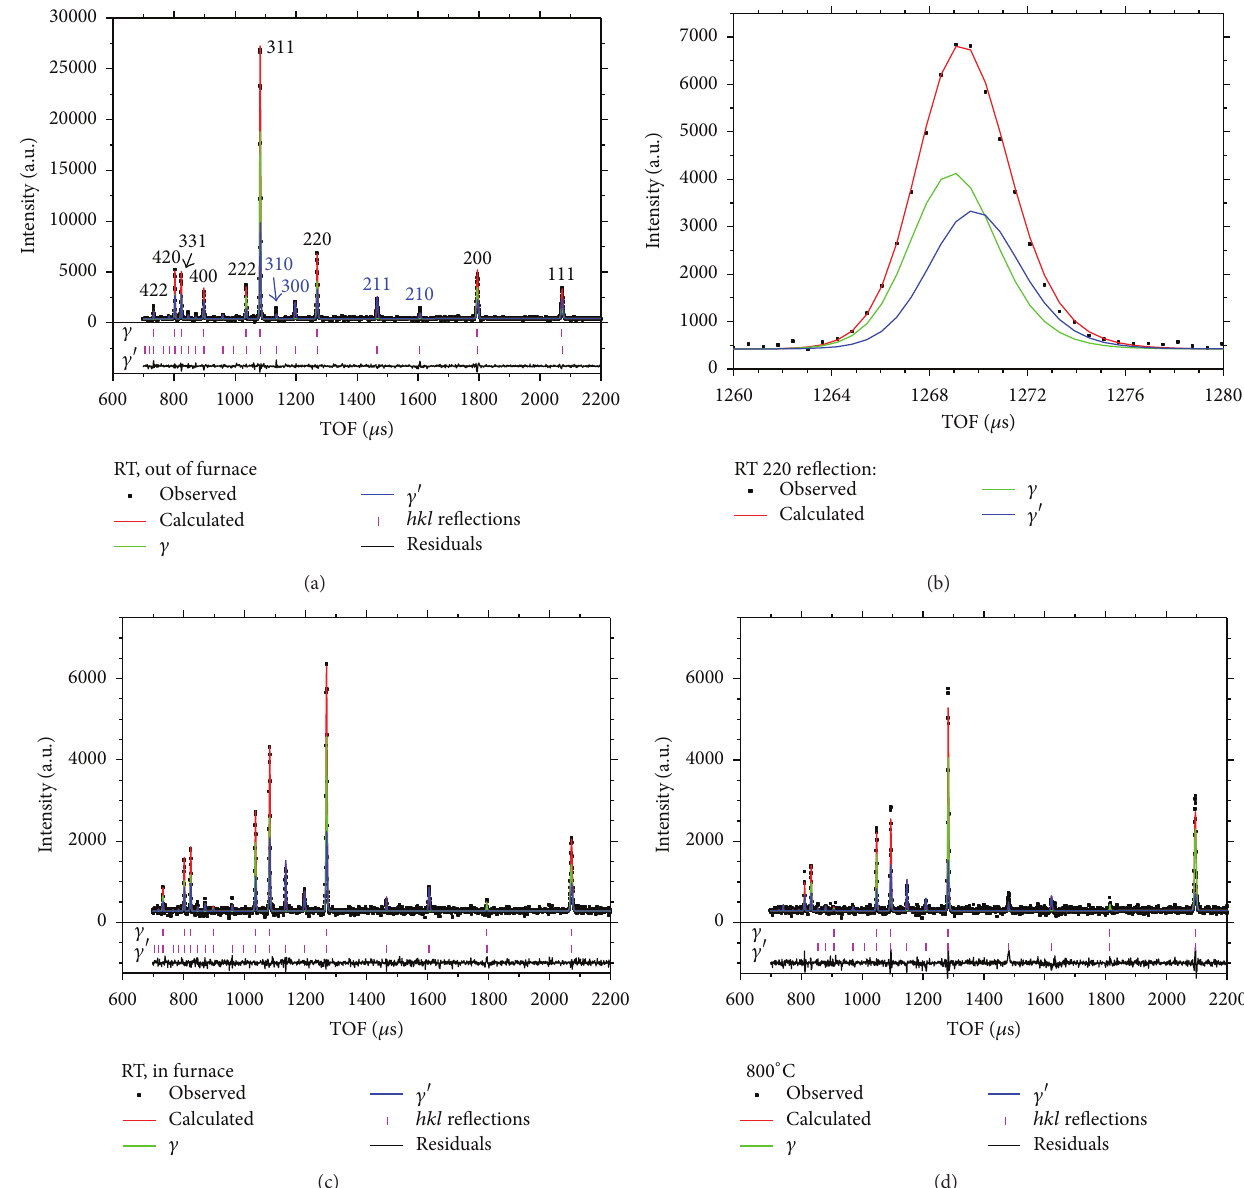
Figure 3: Examples of measured diffractograms of IN738LC. The fit by FullProf, decomposed also to its 𝛾 and 𝛾 󸀠 parts, is plotted, too: (a) out-of-furnace (RT) measurement, (b) detail of 220 reflection for out-of-furnace measurement, (c) in-furnace (RT) measurement, and (d) in-furnace measurement at 800 ∘ C. The residuals (observed minus calculated intensity) are shown as well on the bottom part of Figures 3(a), 3(c), and